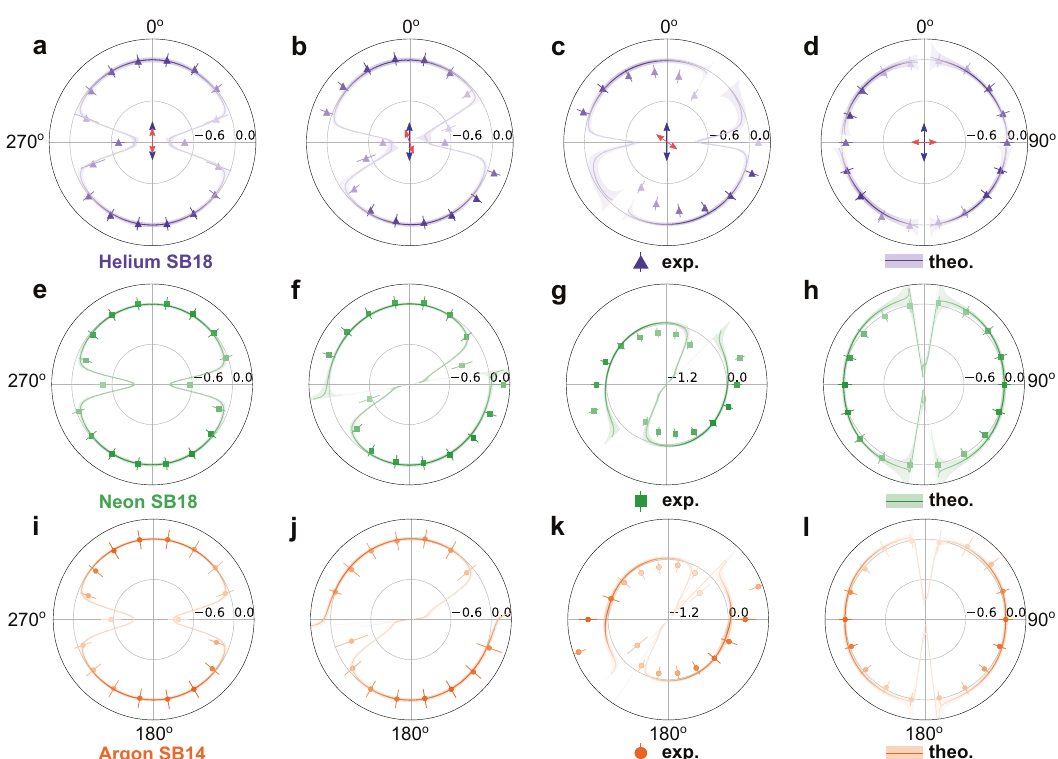
Fig. 2 | Angle-resolved atomic relative phase shift. a – d The normalized atomic results, respectively. The error bars in the experimental results represent the ð θ Þ , in units of π radians as a function of the pho- phase shift distributions, Δ ϕ Θ T standard deviation. The shaded area indicates the fi tting error uncertainty and the rel line colors are weighted by the yield of the photoelectron angular distribution. toelectron emission angle of helium ata skew-angle of Θ T =( a ) 0 ∘ , ( b ) 20 ∘ , ( c ) 54.7 ∘ , e – h , i – l As a – d but for the SB18 of neon and SB14 of argon, and ( d ) 90 ∘ . The triangles and solid lines show the experimental and theoretical